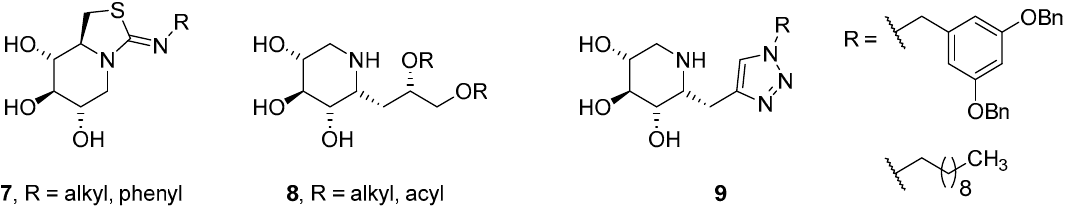
Figure 2. Selected structures of iminosugar based glycomimetics.